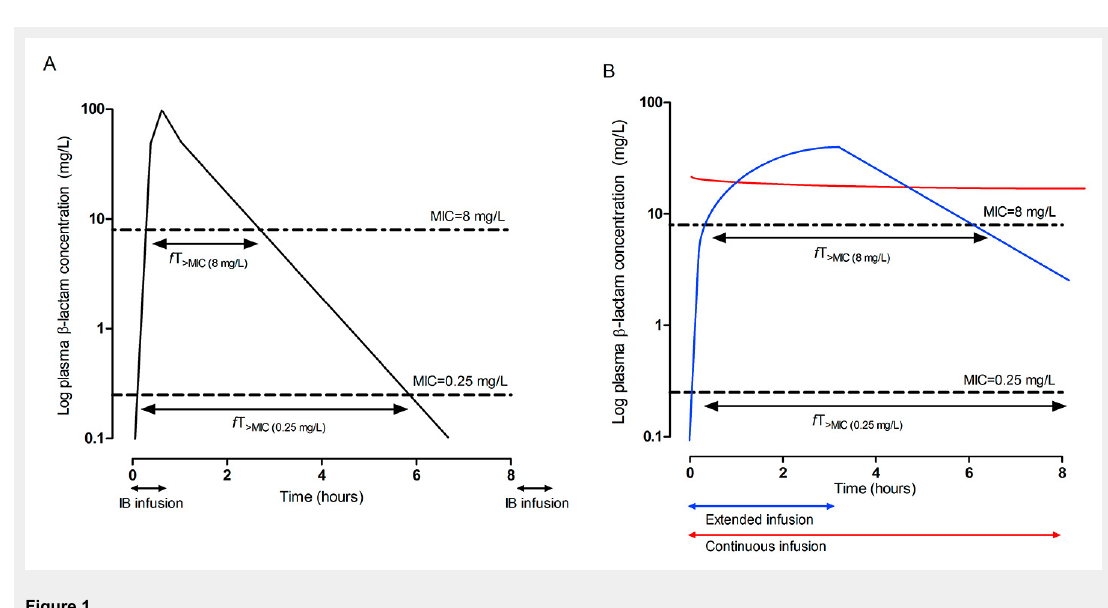
Figure 1 Differences in the time that β-lactam concentrations exceed the MIC ( f T >MIC ) of two different pathogens (MIC of 0.125 mg/l and 8 mg/l, respectively) according to the mode of β-lactam administration. (A) Intermittent bolus administration. (B) Extended infusion (blue line) and continuous infusion (red line). IB = intermittent bolus administration; MIC = minimal inhibitory concentration; f T >MIC = time that the free drug concentration is above the